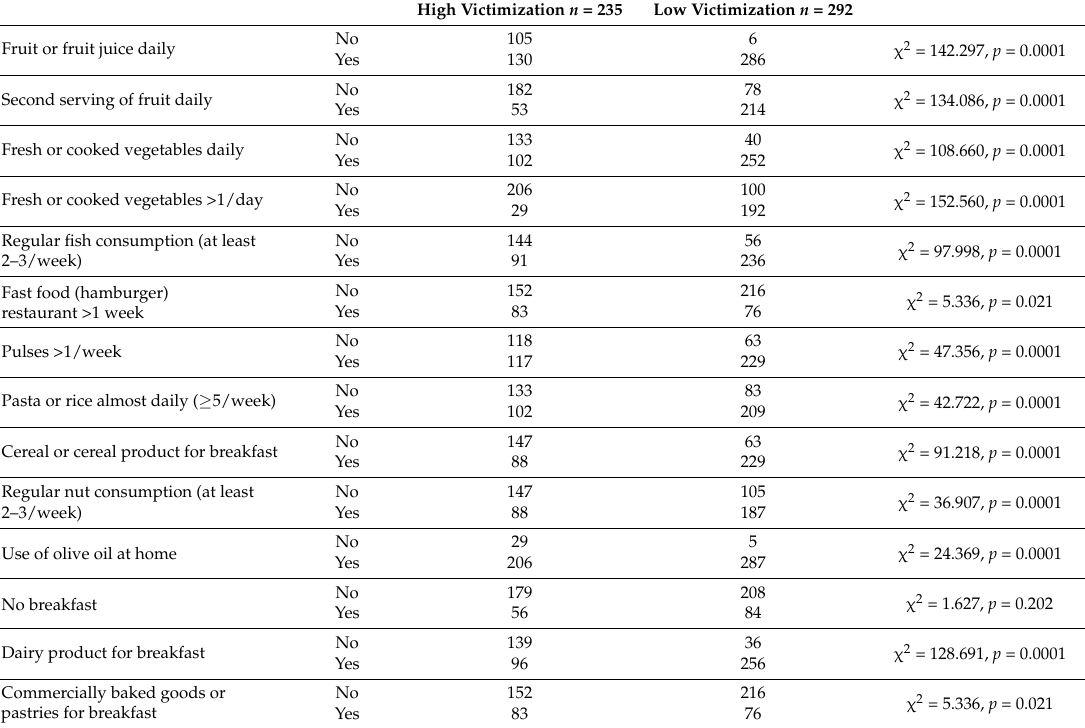
Table 2. Differences between high- and low-victimized adolescents in dietary